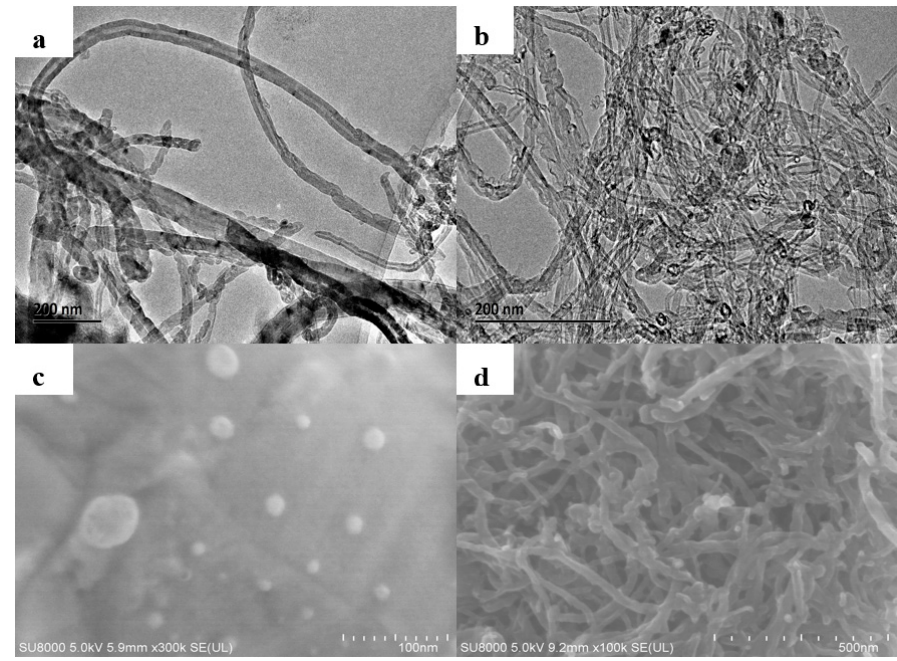
Figure 2. TEM Micrographs of the MWCNTs ( a ), Au/MWCNTs composites ( b ) and SEM micrographs of Au NPs ( c ), Au/MWCNTs composites ( d ).